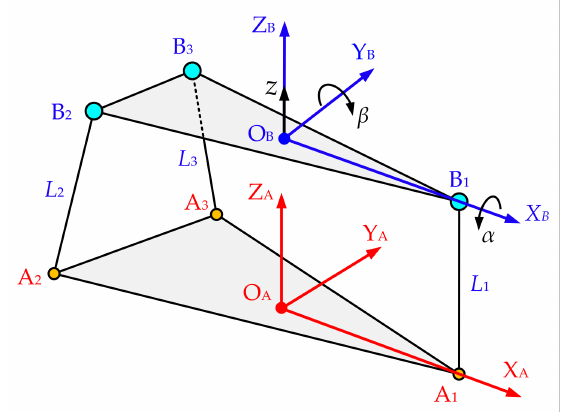
Figure 9. Equivalent 3-DOF parallel mechanism and the coordinate